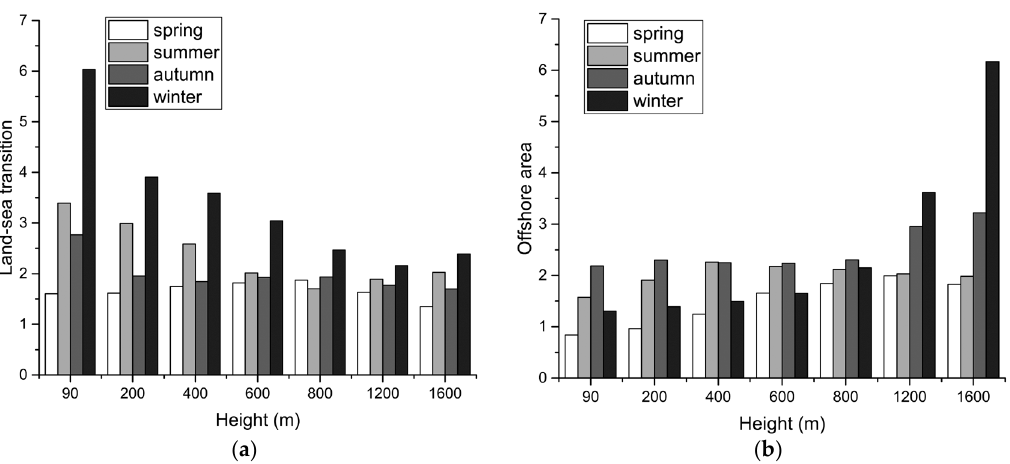
Figure 9. The RMSE of the normal-day simulations in land-sea transition and offshore area: ( a ) the land-sea transition; and ( b ) the offshore area.